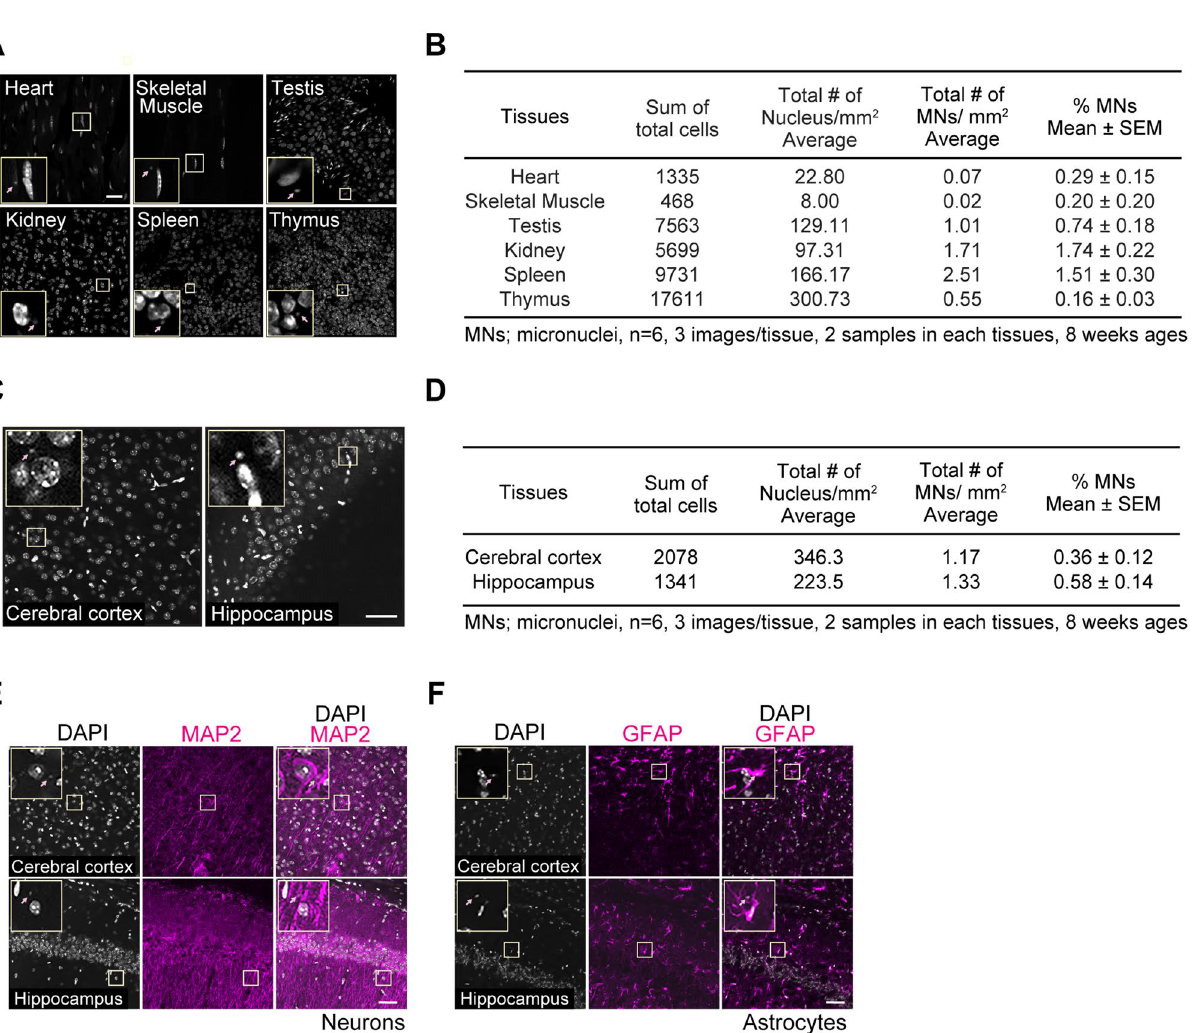
tously. To summarize these observations, micronuclei exist in not only tumor tissues but also in various tissues of wild-type mice.